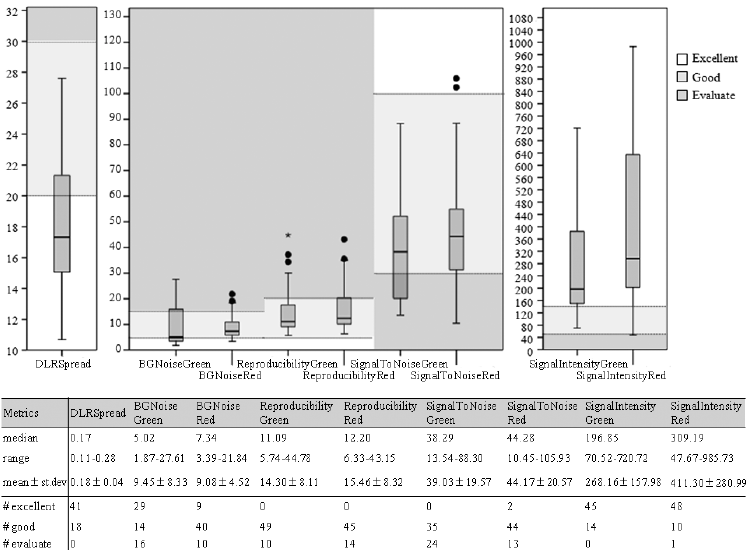
Figure 1. Quality control metrics: Distribution of the sample quality controls is reported as box plots and as statistics. In particular, sample metrics are highlighted as excellent, good or poor (evaluate) and how many samples are in each category is also reported. Solid circles and asterisks in the box plot graphs represents the outliers: solid circles are cases with values more than 1.5 times the InterQuartile (IQ) range, asterisks are cases with values more than 3 times the IQ range.